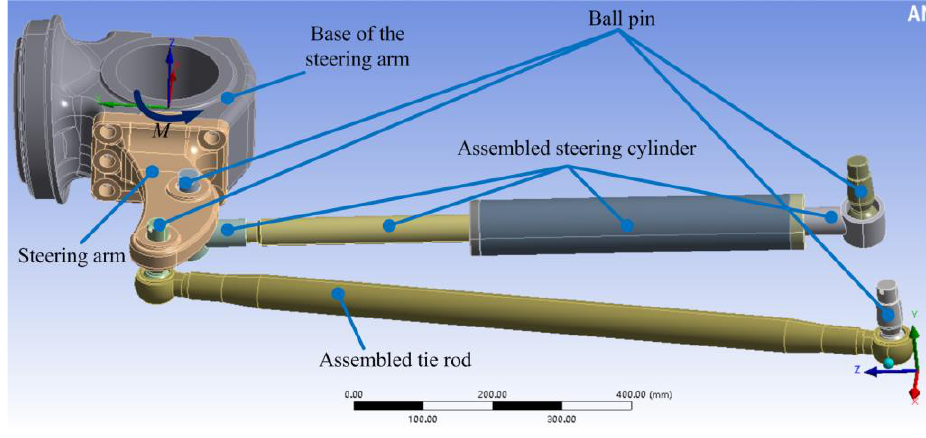
Figure 7. Left steering mechanism.